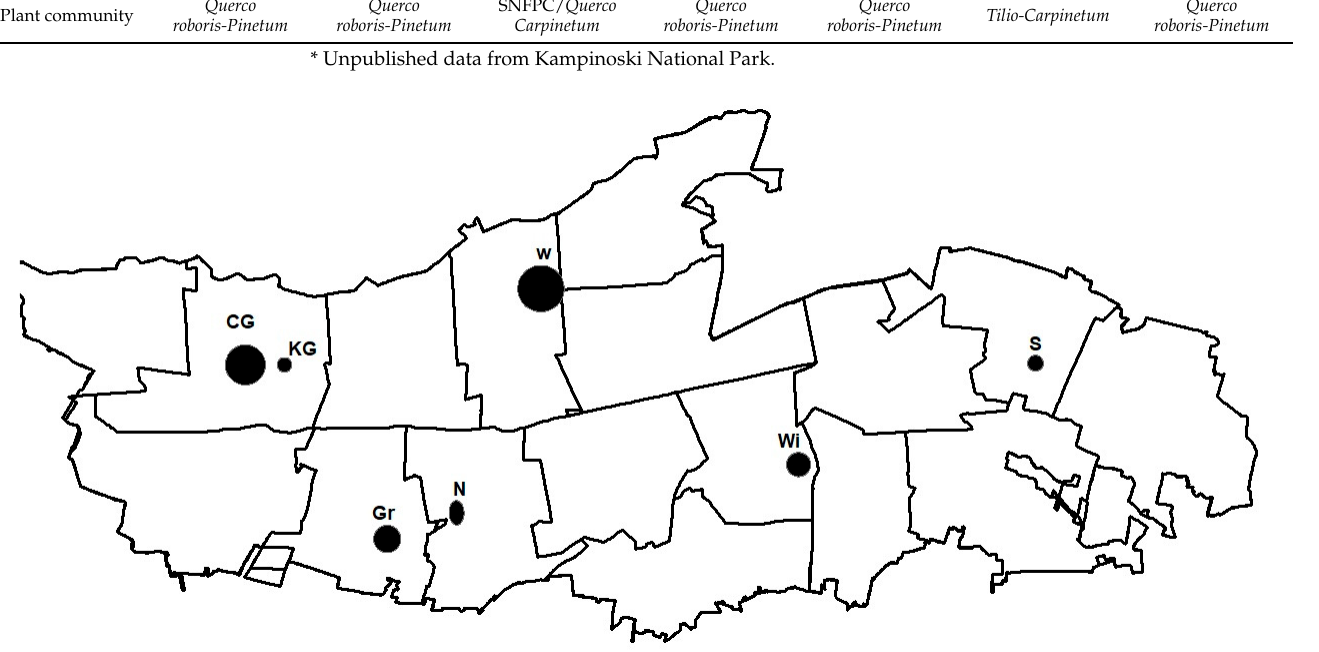
Table 1. The characteristics of the study locations.